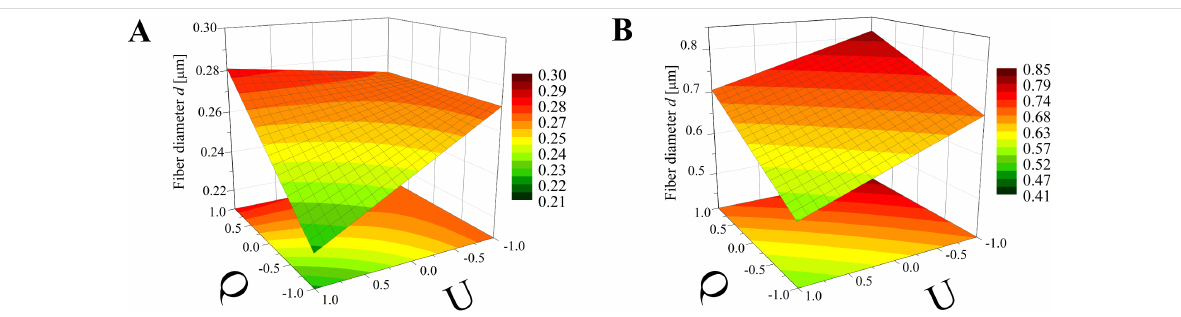
Figure 9: Response surface plots presenting the dependence of the diameter of the obtained beaded fibers ( d ) on the electrical voltage ( U ) and the flow rate ( Q ) of the polymer solution for (A) minimum dynamic viscosity (µ = − 1) and (B) maximum dynamic viscosity (µ =